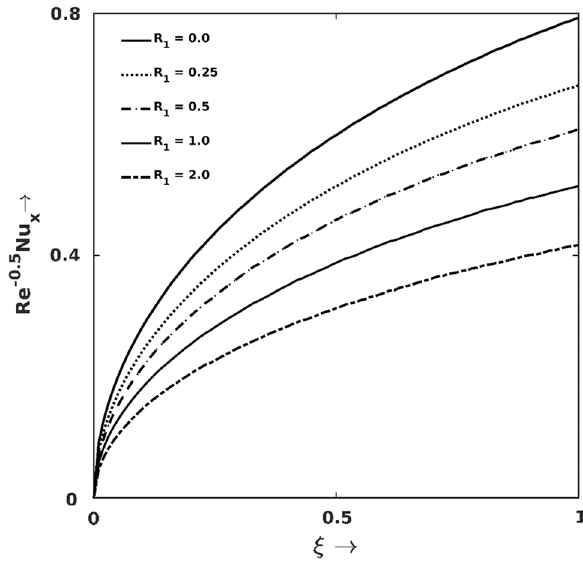
Figure 6. Nusselt number (cid:31) Nu x